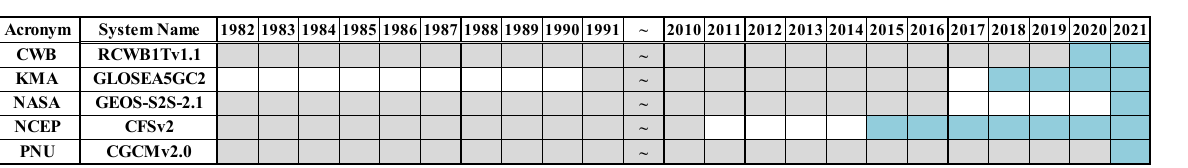
Figure 1. CGCM data used in this study: coverage with individual model historical and real-time forecasts. The cyan, gray, and white box indicated forecast, hindcast, and no data, respectively. Reanalysis data were used as observation for the prediction skill assessment. The fields of Z500 is those from European Centre for Medium-Range Weather Forecasts (ECMWF) Reanalysis v5 (ERA5) data (0.25° ⨉ 0.25°) [36]. The SST data is NOAA Opti- mum Interpolation (OI) Sea Surface Temperature (SST) V2 (OISSTv2) data (1.0° ⨉ 1.0°) [37]. All observation data were interpolated to the model grid.